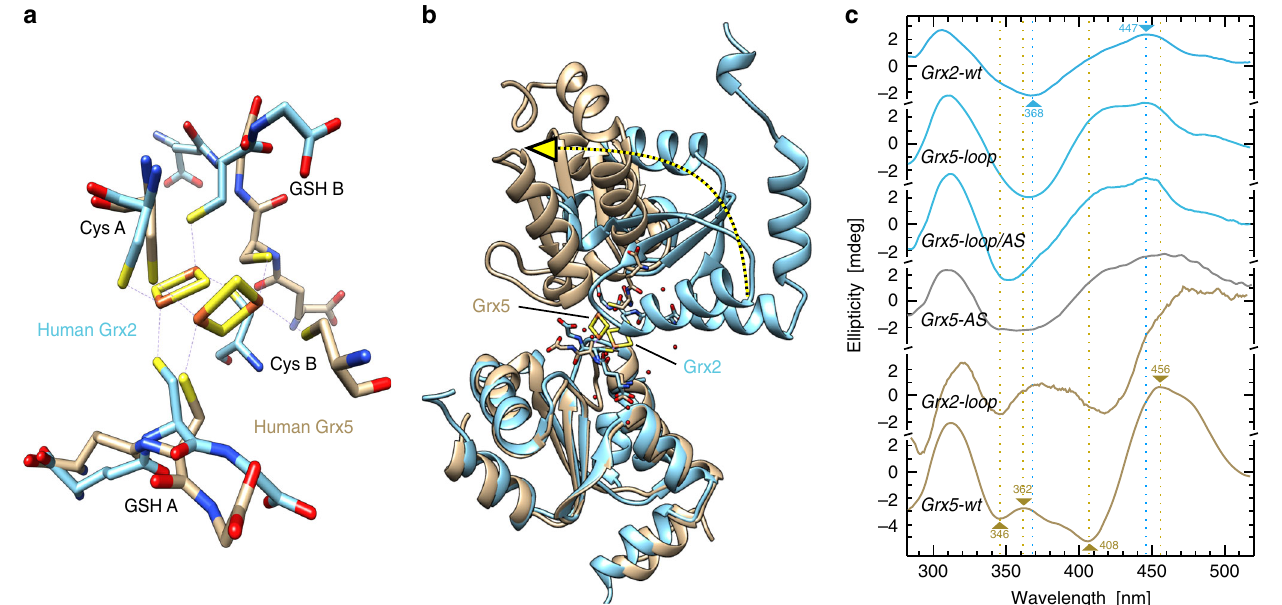
Fig. 6 The distinct loop structures determine the conformations of the holo-complexes. a , b Comparison of the dimeric holo-complexes of the CxxC/S- type Homo sapiens Grx2 (blue, PDB 2HT9) and the CGFS-type Homo sapiens Grx5 (brown, PDB 2WUL). The alternate positions of the Fe 2 S 2 clusters are indicated ( a ) as well as the rotation of the second monomer induced by the shift and rotation of the FeS cluster ( b , dotted arrow). The second dimer present in the 2WUL structure was omitted for clarity. c Circular dichroism spectra of the wild-type and engineered proteins as indicated. The concentration of the FeS holo-proteins was adjusted to 175 µ M using the molar absorptivity of the FeS clusters for all CD spectra recorded. Blue curves represents the proteins with the CxxC/S-type loop, brown curves the proteins with the CGFS-type loop, the gray curve Grx5 with the CSYC active site of Grx2. Source data are provided as a Source Data fi